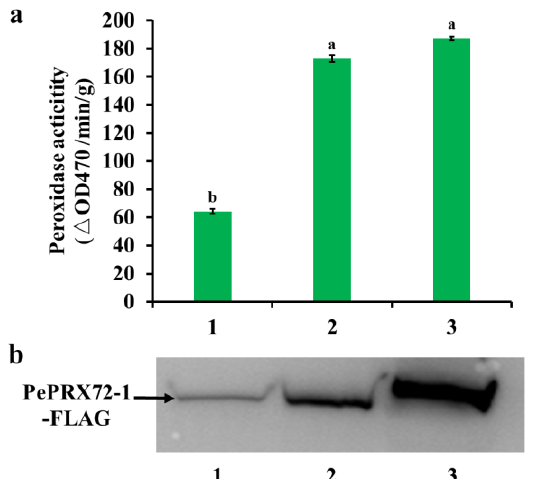
Figure 8. PeKFB9 attenuated the stability of PeRX72-1. ( a ) Peroxidase activity in crude extracts from tobacco leaves co-expressing PePRX72-1 with PeKFB9-FLAG (1), F^PeKFB9-FLAG (2), and pCAMBIA1300-3×FLAG (3). Data are the mean ±SD from three biological replicates. Different letters indicate significant differences ( p < 0.01). ( b ) Immunoblot detection of the stability of the PePRX72-1-FLAG fusion proteins using anti-FLAG antibody in tobacco leaves co-infiltrated with PeKFB9-FLAG (1), F^PeKFB9-FLAG (2), and pCAMBIA1300-3×FLAG (3) constructs.